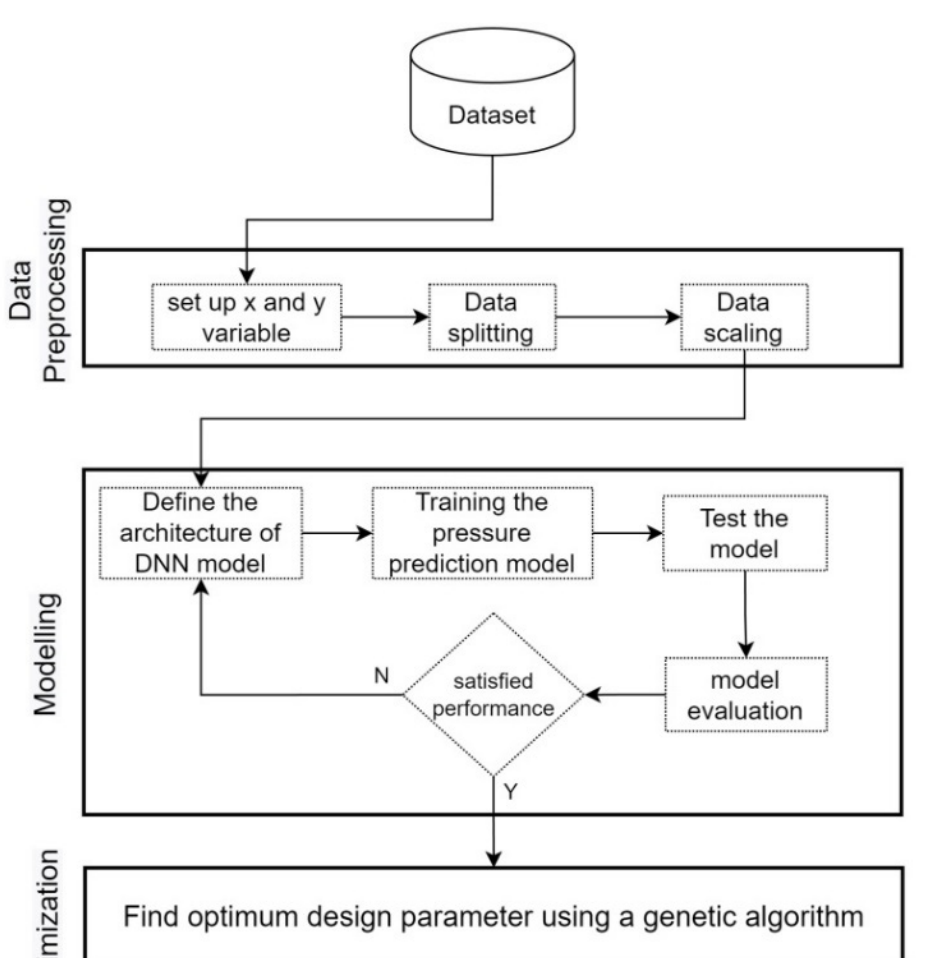
Figure 1. A conceptual framework of the proposed approach.